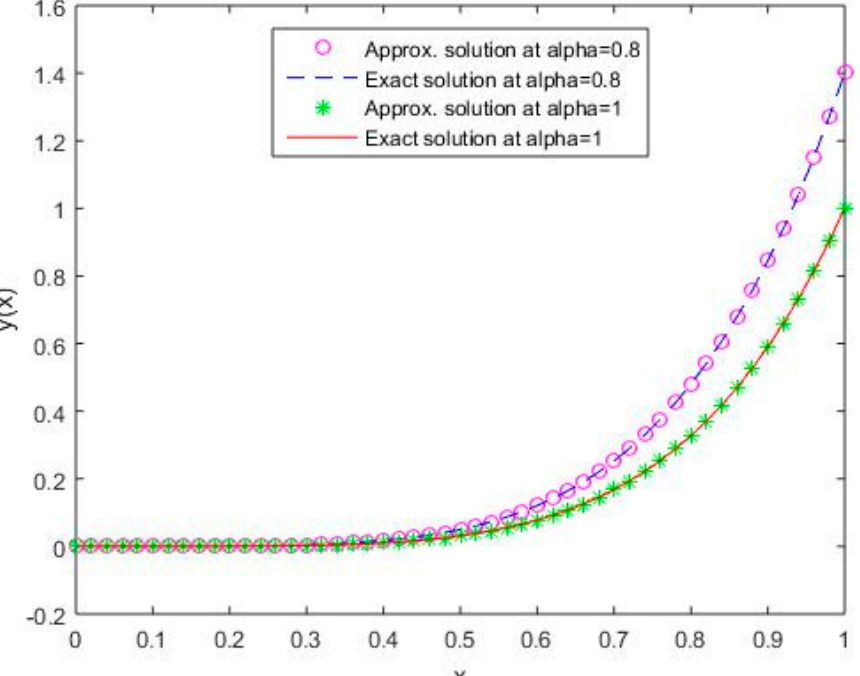
Figure 3. Comparison of exact and numerical solutions using S3 for 𝛼 = 0.8 and 𝛼 = 1 , Example 1.